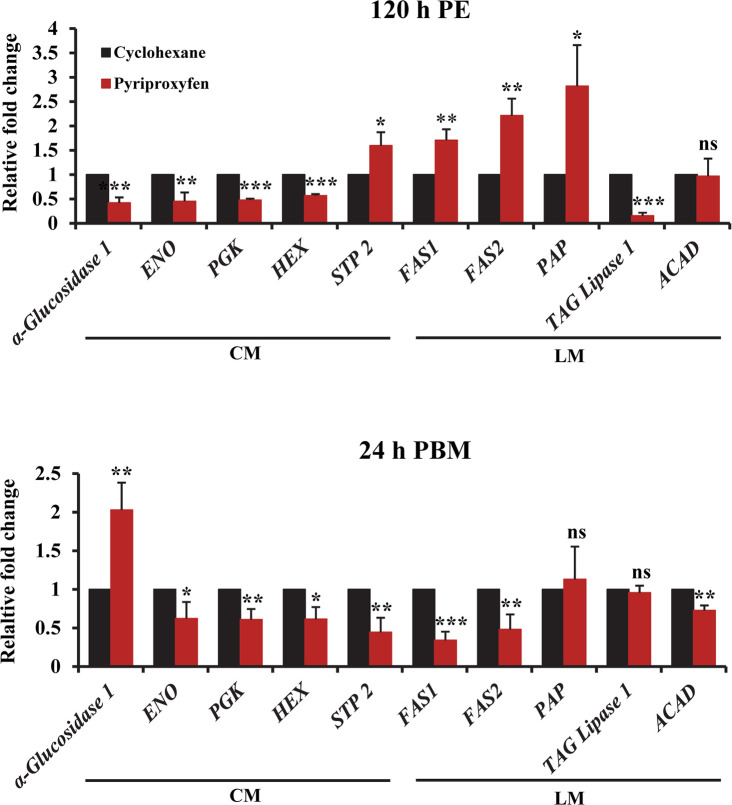
PPF treatment altered the expression of metabolic genes.Female mosquitoes were treated with PPF at 72 h PE. Quantitative RT-PCR assays were performed to compare the expression of selected genes involved in carbohydrate metabolism (CM) and lipid metabolism (LM). mRNA levels were measured in the fat body at 120 h PE and 24 h PBM. Data are presented as mean ± SD from three independent replicates. Statistical analyses were performed using paired t-test (ns, p > 0.05; *, p < 0.05; **, p < 0.01; ***, p < 0.001).